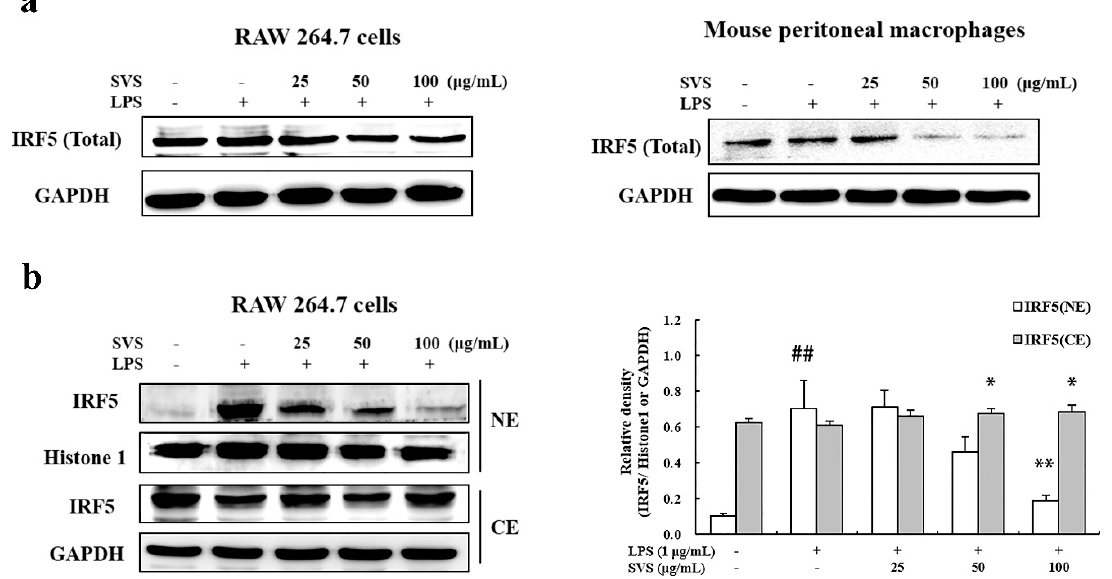
Figure 7. Stevioside repressed LPS-induced IRF5 activation in macrophages. RAW 264.7 cells were pretreated with or without the indicated concentrations of stevioside for 1 h and then stimulated with LPS (1 µ g/mL) for 1 h. Whole cell lysate ( a ) or nuclear and cytosolic extracts ( b ) were isolated and subjected to immunoblots. GAPDH was used as an internal control for whole cell lysate and cytosolic extracts while histone 1 was used as internal control for nuclear extracts. The right panel in b is the quantification of the left panel, as measured by Image J. Experiments were repeated three times, and similar results were obtained. Data are presented as means ± S.D. of three independent experiments. ## p < 0.01 versus control group; * p < 0.05, ** p < 0.01 versus LPS-treated group. SVS, stevioside.